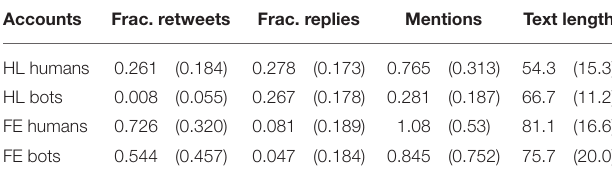
TABLE 2 | Classifiers